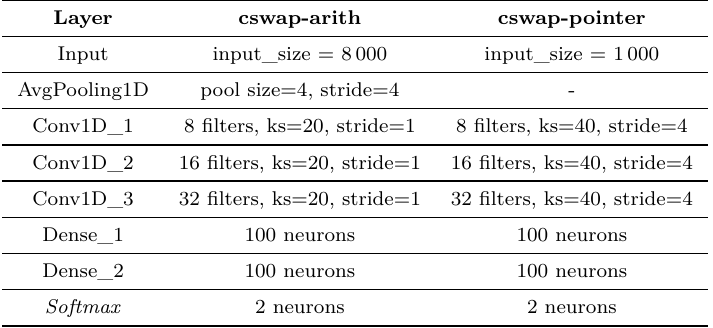
Table 2: CNN architectures considered for the two datasets described in Section